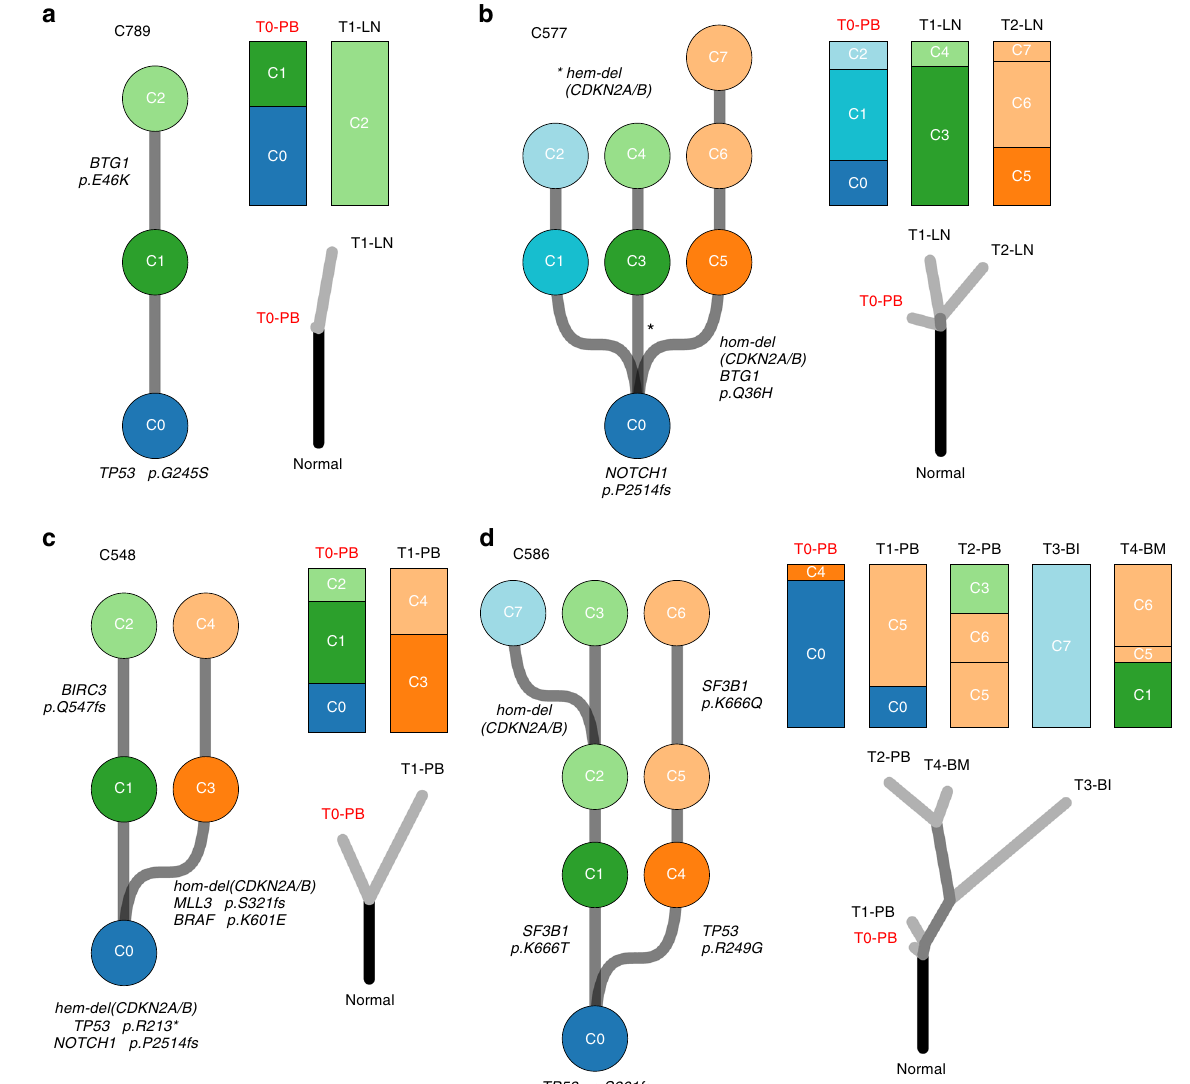
Fig. 2 Heterogeneous clonal evolutions under venetoclax therapy. Phylogenetic trees at the left side of each panel demonstrate the clonal evolution of the reconstructed cell populations for each patient. Highlighted mutations that occurred during tumor evolution are present in all descendent clones. Therefore, mutations in the most common ancestor population (C0) are present in all analyzed samples at a clonal level. The second type trees (right-bottom of each panel) demonstrate the phylogenetic relations of the matched pre-treatment and relapse samples from a patient, as commonly used in other cancer evolution studies 10,13 . Clonal composition of the samples (top-right of each panel) provides a link between both types of phylogenetic trees. We inferred diverse evolutionary paths across the patients: a linear evolution (C789), b branching evolution into three lineages (C577), c divergent evolution of two branches (C548), and d convergent evolution (C586). Pre-treatment sample names are displayed in red. Notable gene alterations are shown in the context of the ancestral relation of the the rapidly proliferating (Ki67-score of 90%) extranodal disease venetoclax resistance with a half-maximal growth inhibitory manifestation inside the right radial bone (T3-BI) was completely concentration (GI 50 ) larger than 10 μM in contrast to the empty dominated by the single subpopulation C7, which carried a vector control: GI 50 = 0.43 μM (Fig. 3b). In another venetoclax- homozygous loss of CDKN2A/B . sensitive cell line (U-2932) overexpression of the mutated BRAF V600E led only to a slight increase of the GI 50 value (from 0.72 μM for the empty vector control to 0.99 μM; Supplementary Fig. 6a). A reanalysis of published whole-exome-sequencing data 25 of U-2932 showed mutated TP53 together with a loss of 17p, but no alterations in CDKN2A/B . In both cases, the expression of mutant BRAF V600E is paralleled by an increase in MCL1 protein levels. Next, we tested if a loss of CDKN2A/B alone can lead to venetoclax resistance and deleted the gene in the cell line OSU 26 , using the CRISPR/Cas9 system. We found no dif- ference in venetoclax sensitivity between OSU wild-type and